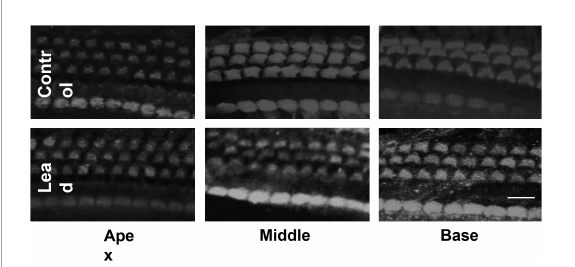
FIGURE3 Effect of lead exposure on hair cell viability. Surface preparations of organ of Corti stained with anti-myosin 7a are illustrated. The outer and inner hair cells in the lead-exposed mice appear similar to that of controls and no hair cell loss was observed in all three turns of the organ of Corti. Images are representative of six replicates. Scale bar = 20 µ